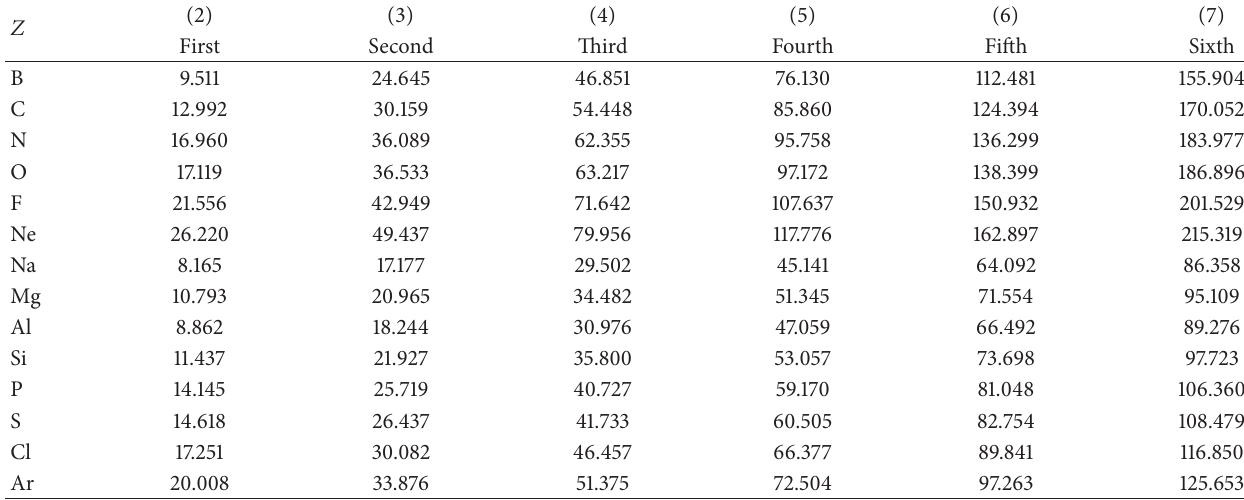
Table 10: Ionization energies (eV) calculated using coefficients in Table 9.